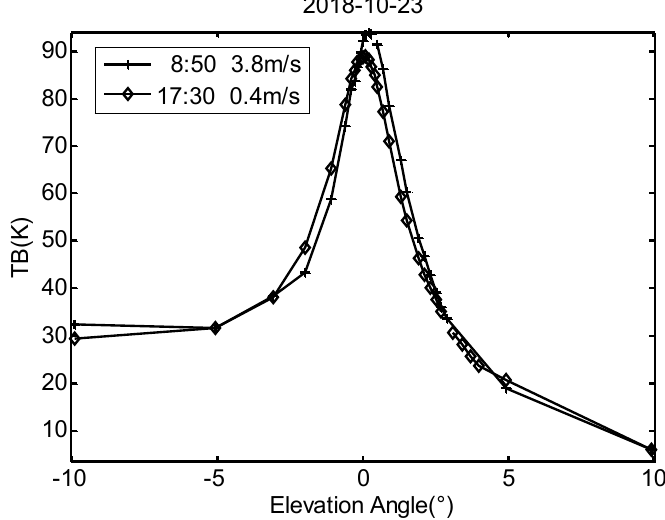
Figure 4. Measured data of the X-band horizontal polarization upwelling TBs against the elevation angles. The pluses in the figure are the TB data measured at 8:50 on 23 October 2018, and the diamonds in the figure are the TB data measured at 17:30 on the same day. The average wind speeds at 8:50 and 17:30 were 3.8 m/s and 0.4 m/s, respectively.